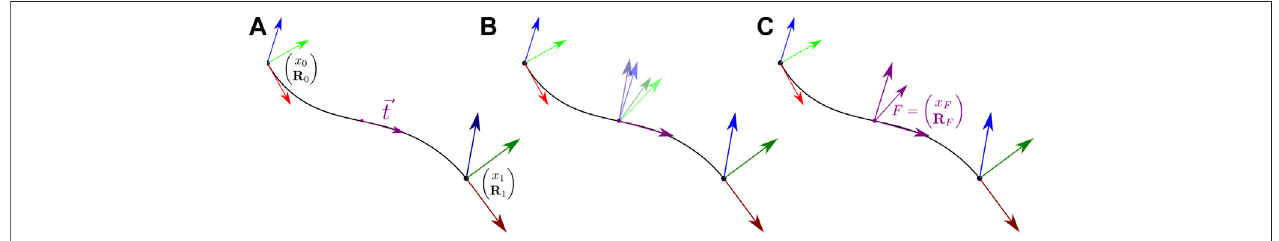
FIGURE3| Toconstruct R F we fi rstevaluatethetangentatthecubicBéziercurvemid point (A) Wethentransform each beamend pointorientationtoalignits fi rst axis with the mid point tangent (B) We fi nally compute the orientation of F by taking the average of these two rotations (C) .